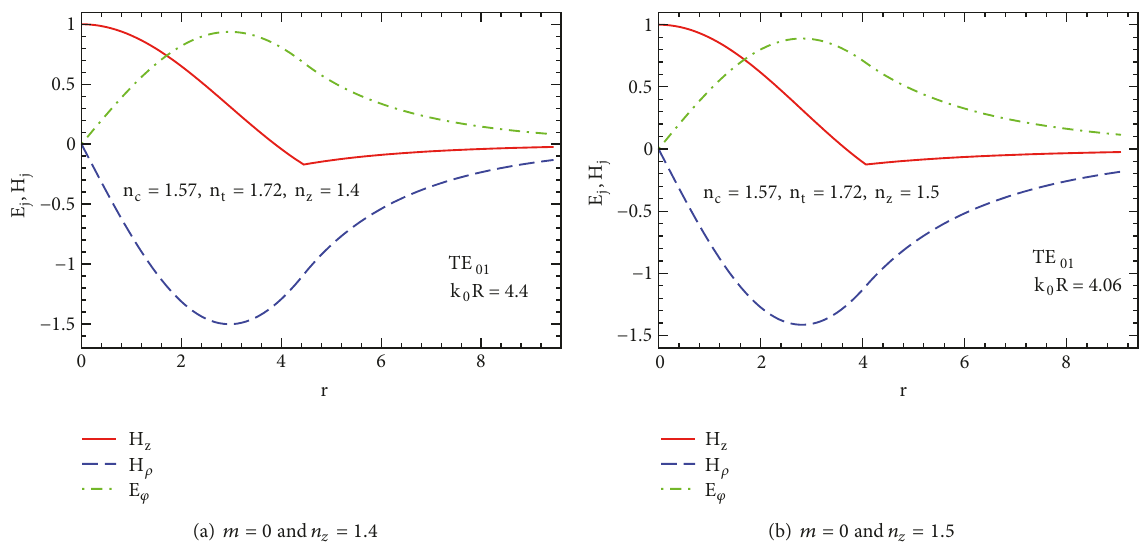
Figure 3: Electromagnetic field versus the dimensionless radial parameter 𝑟 = 𝑘 0 𝜌 for the mode TE 01 ( 𝐸 𝑧 = 0 ) at (a) 𝑛 𝑧 = 1.4 and (b) 𝑛 𝑧 = 1.5 .